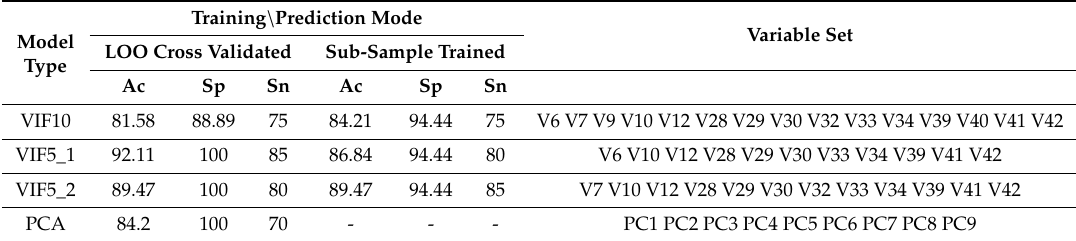
Figure 5. Values of the linear discriminant analysis (LDA) response variable plotted for T2DM (opened diamonds) and control (closed circles) individuals, calculated using selected predictive variable sets (as summarized in Table 3). ( A ) Estimated via leave-one-out cross-validation; ( B ) estimated from original samples, with LDA trained on generated samples. Table 3. Summary of the predictor performance validation under distinct training and performance estimation conditions.